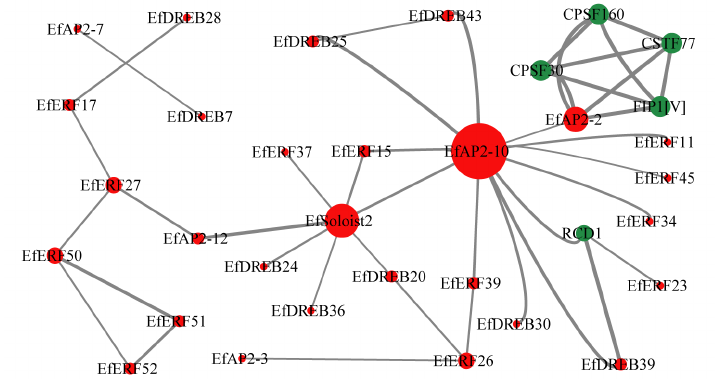
Figure 9. Interaction network of EfAP2/ERF proteins in E. fulvus according to orthologues in Arabidopsis . Each protein is displayed in different-colored circles, red indicating EfAP2/ERF family proteins, and green indicating other protein families.